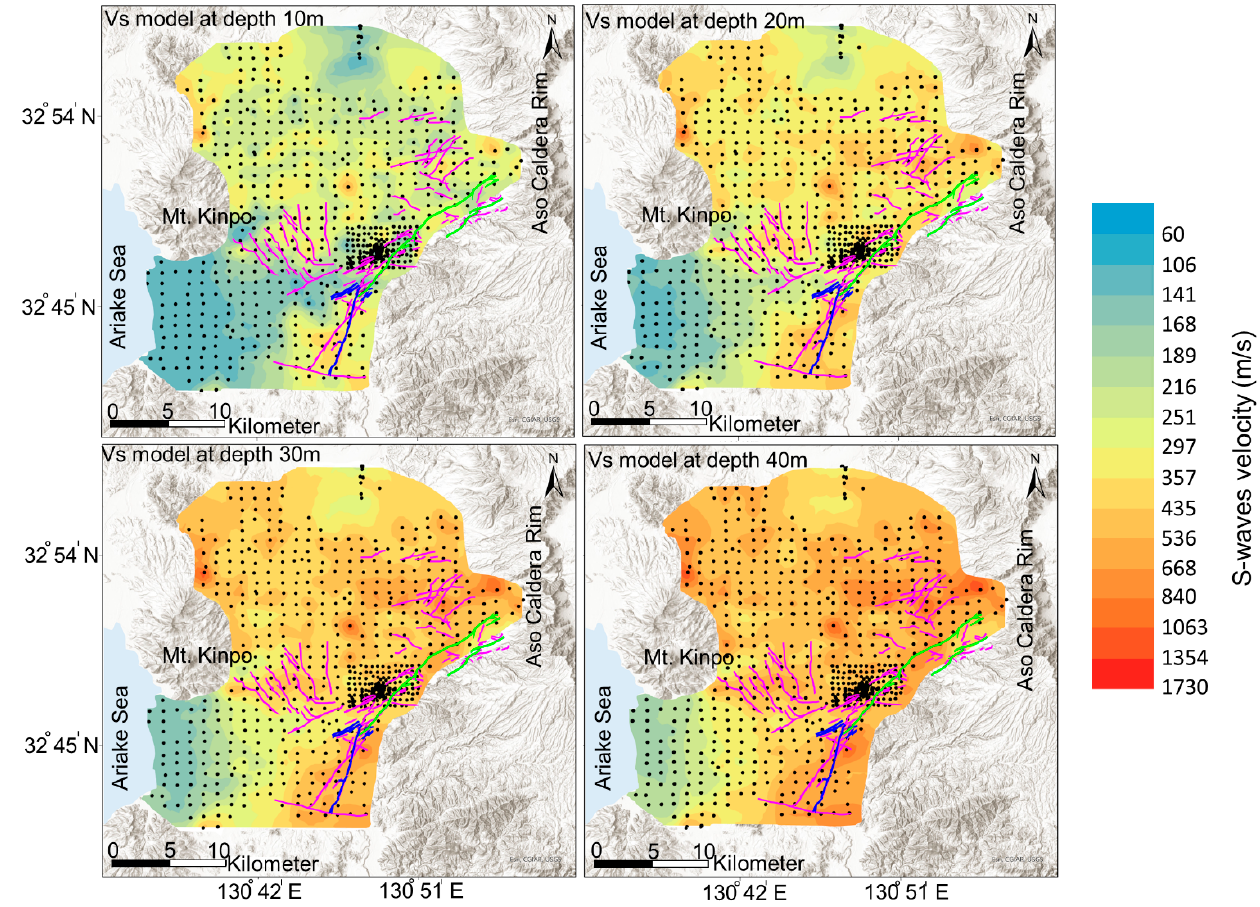
Figure 6. S-wave velocity distribution at depths of 10–40 m. Black dots are Vs observation points. Purple lines are linear surface ruptures mapped using InSAR by Fujiwara et al. [47], and the green and blue lines refer to Futagawa and Hinagu faults [77].